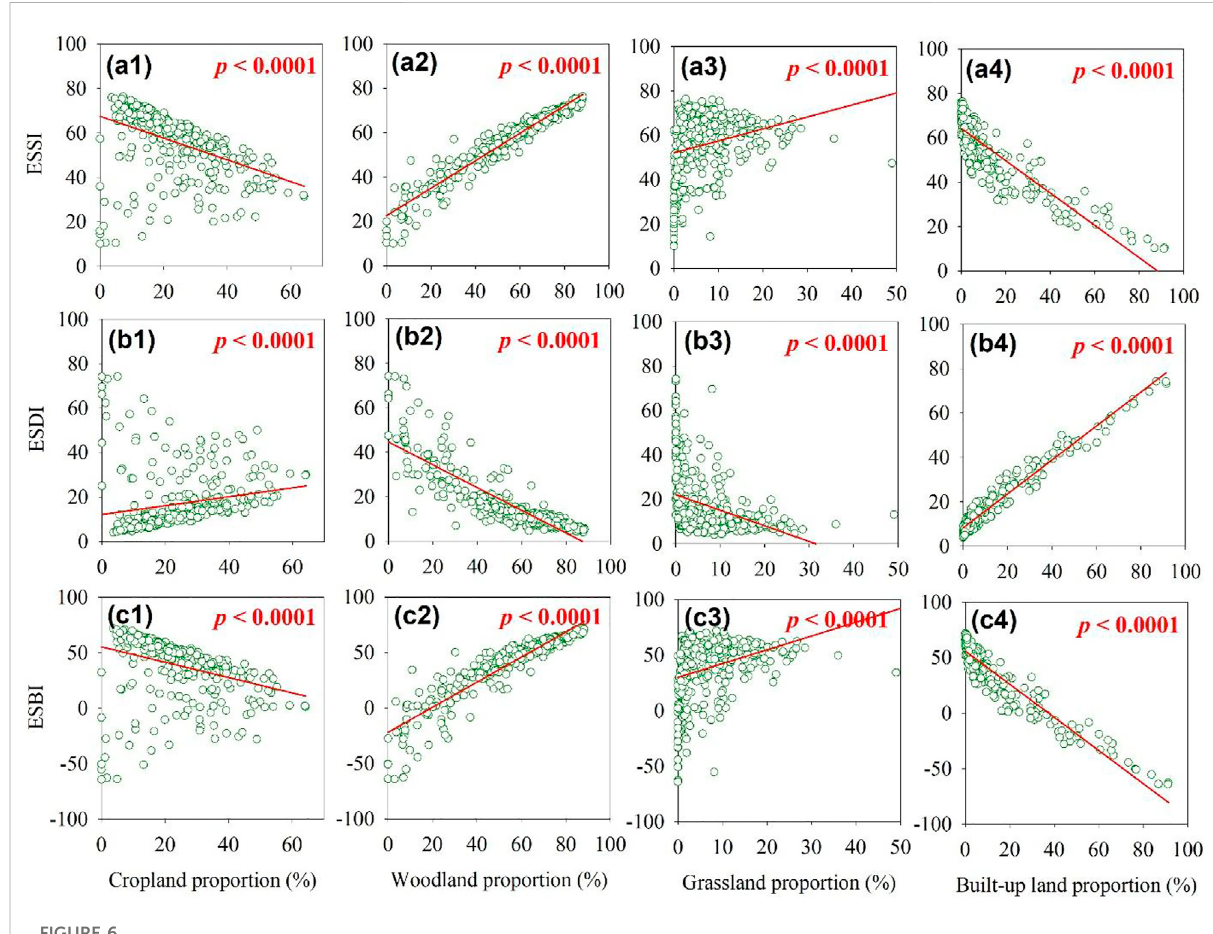
FIGURE 6 Associations between (A) ESSI, (B) ESDI, and (C) ESBI and dominant landscape